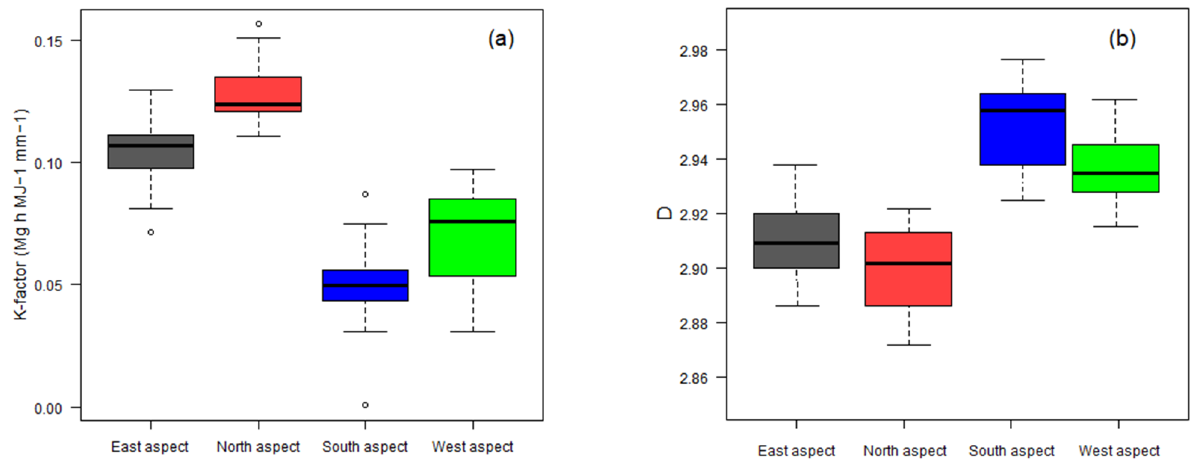
Figure 8. Summary box plots of ( a ) K- factor and ( b ) D, under different aspects ( n =